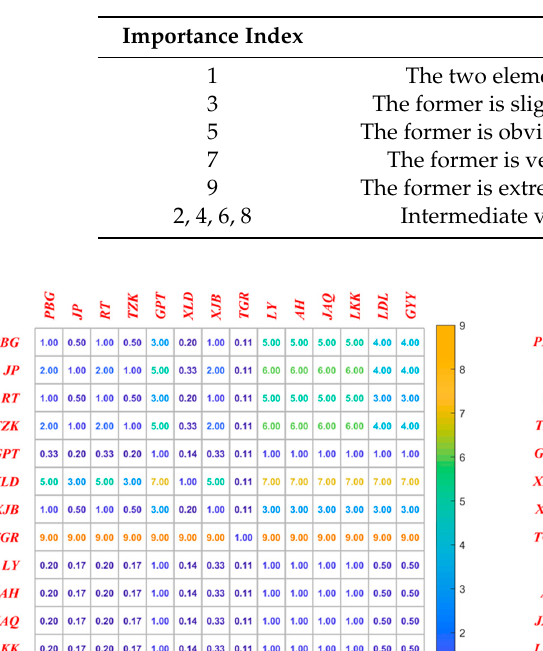
Table 6. Implication of importance scale.